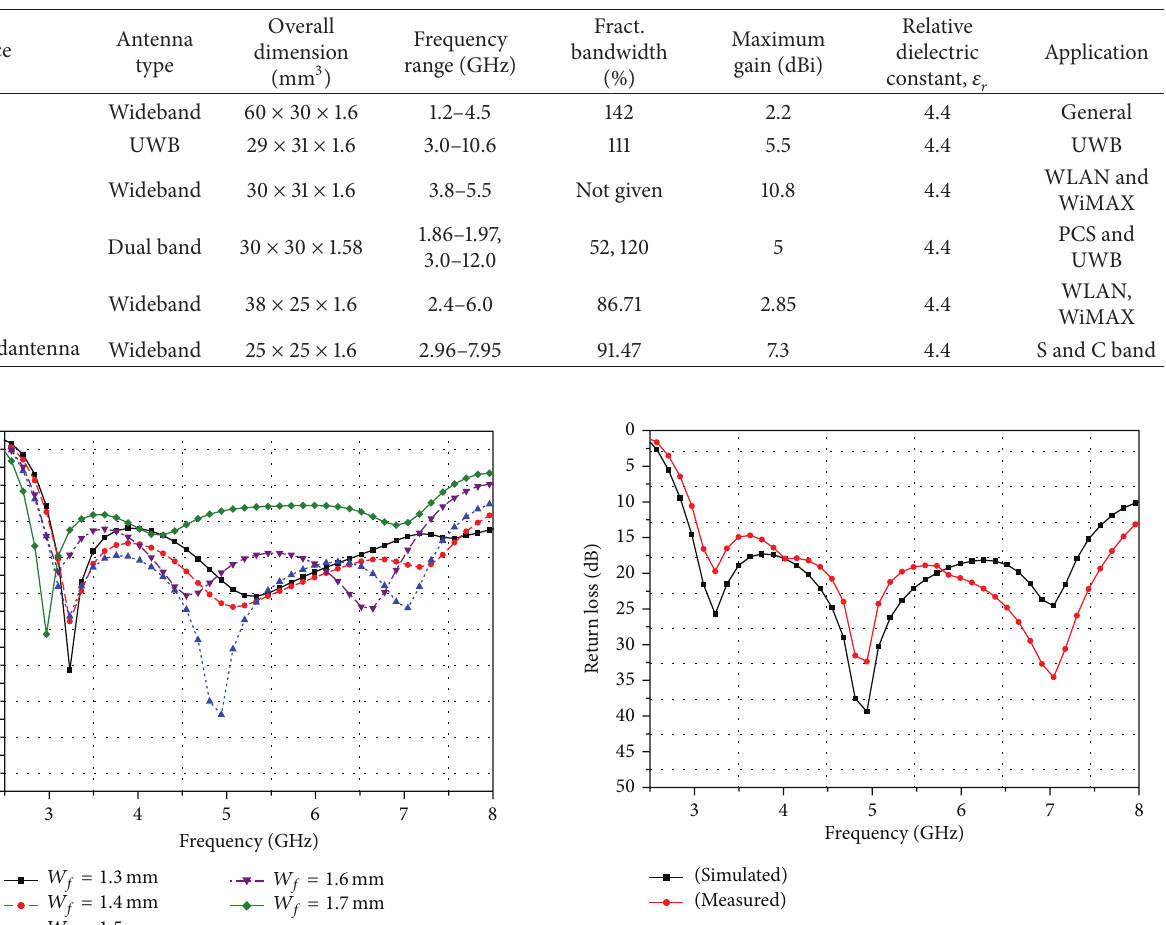
Table 2: Comparison between the proposed antenna and some existing wideband microstrip antenna.